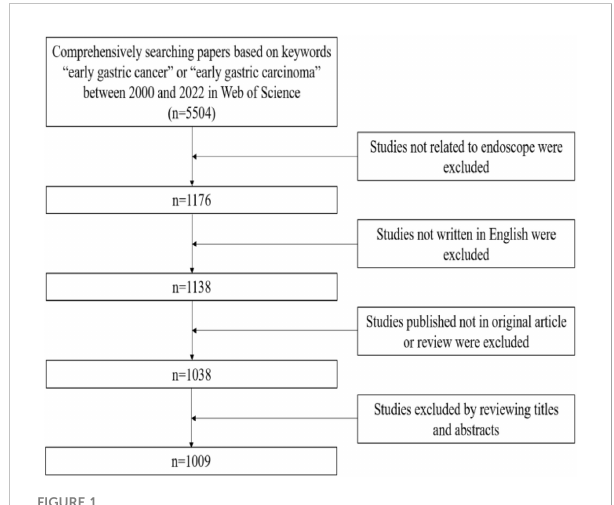
FIGURE 1 Process of paper selection in the endoscope on the EGC.